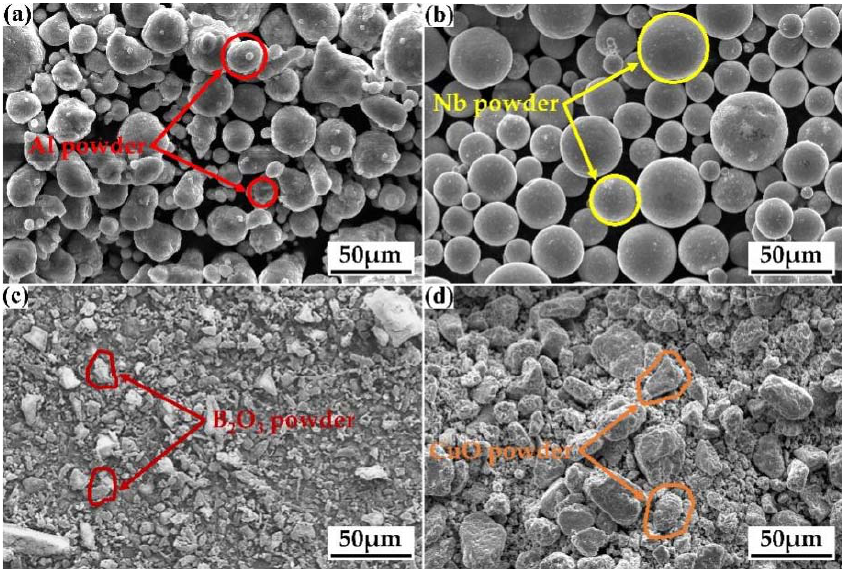
Figure 1. The appearances of the reactants: ( a ) Al powder, ( b ) Nb powder, ( c ) B 2 O 3 powder, and ( d ) CuO powder.